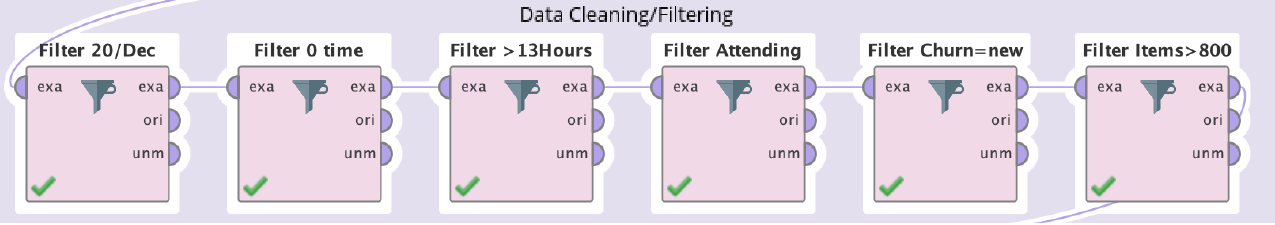
Figure 5. Snapshot of the data transformation process for the traditional approach using RapidMiner.